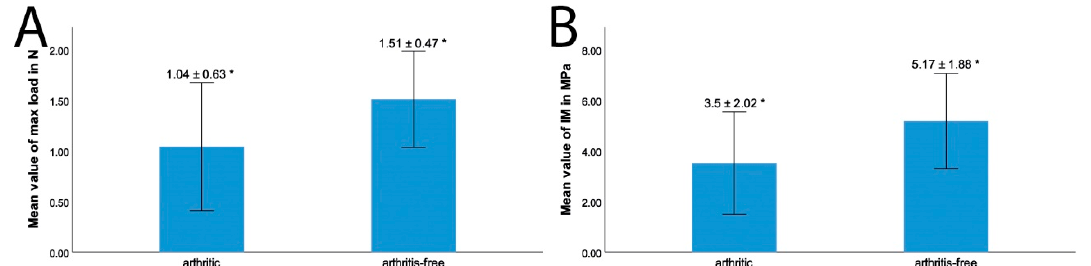
Figure 3. ( A ): Differences in maximum applied load in N over the mid part of the meniscus-covered cartilage ( p = 0.04): arthritic: 1.04 ± 0.63 N (error bar: 1 SD); arthritis-free: 1.51 ± 0.47 N (error bar: 1 SD). ( B ) Differences in IM in MPa over the mid part of the meniscus-covered cartilage tissue ( p = 0.03):